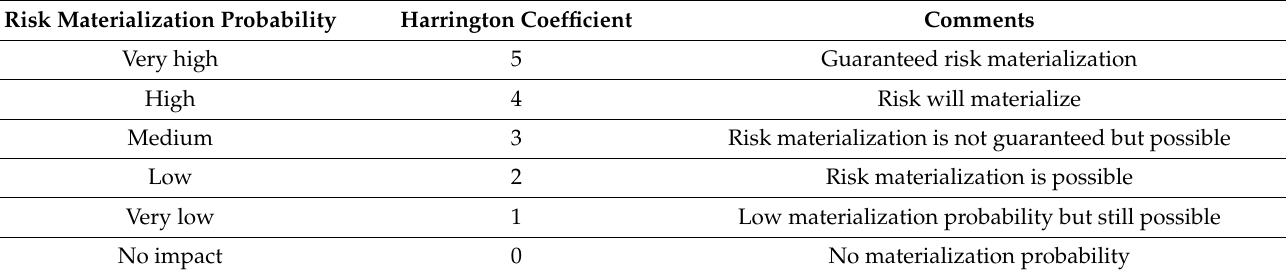
Table 2. Harrington coefficients for assessing the probability of risk